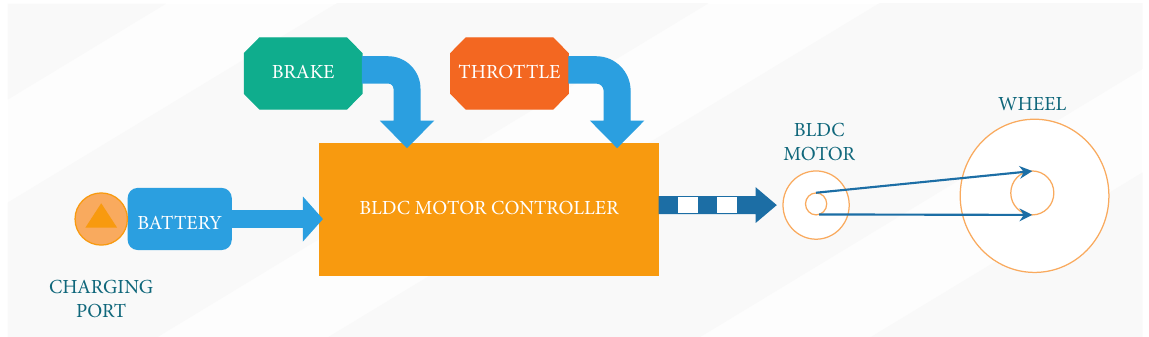
Figure 3: Block diagram of the proposed prototype model of ELECLE 1.0.